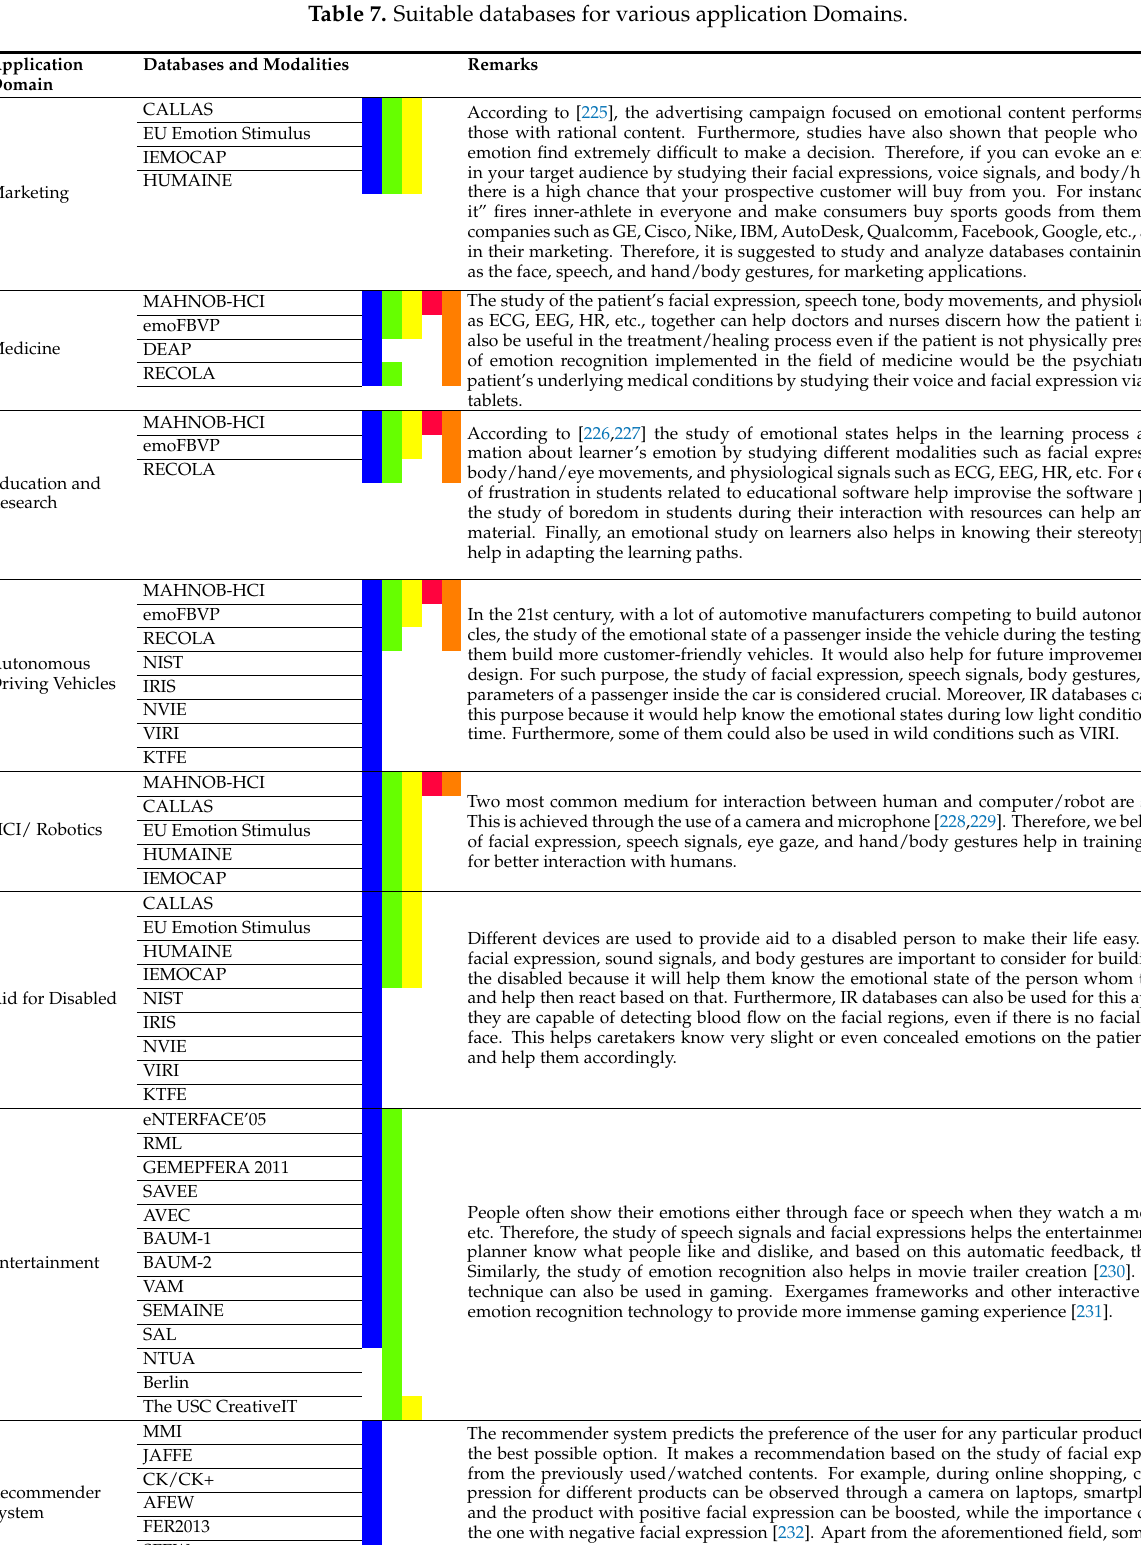
Table 7. Suitable databases for various application